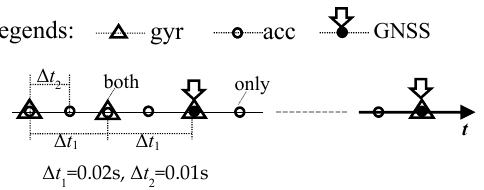
Figure 1. The sequence of the inertial measurement unit (IMU) data of the “Huawei